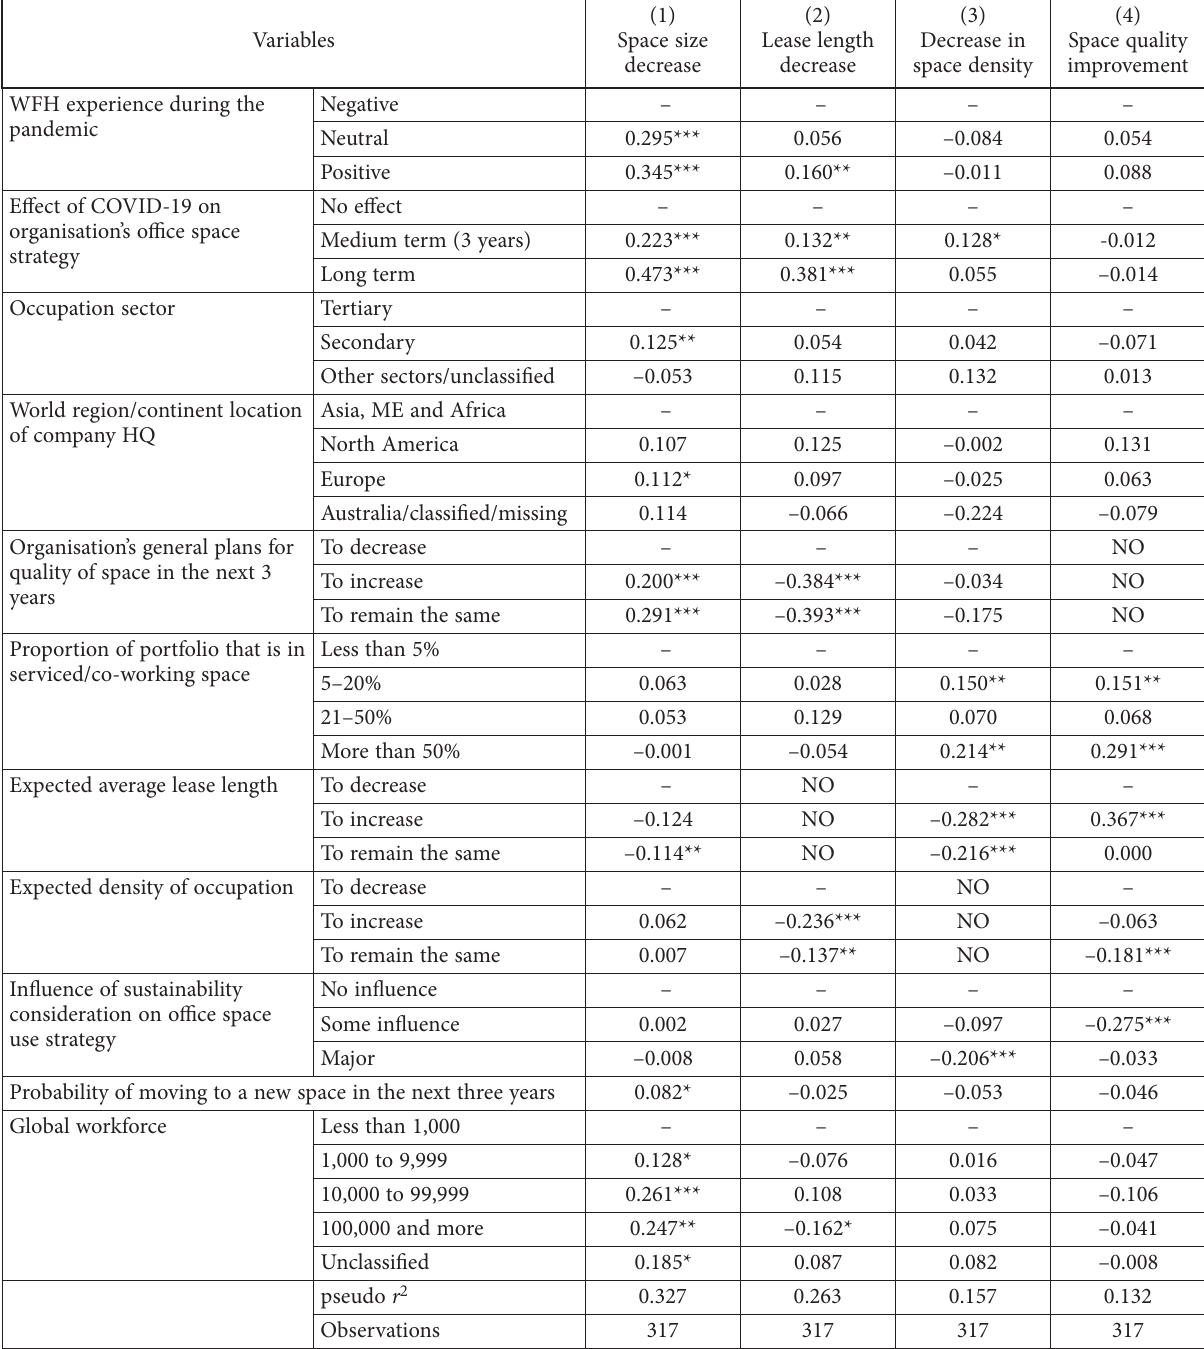
Table 2. Probit showing office space quantity and quality expectation within the next three years